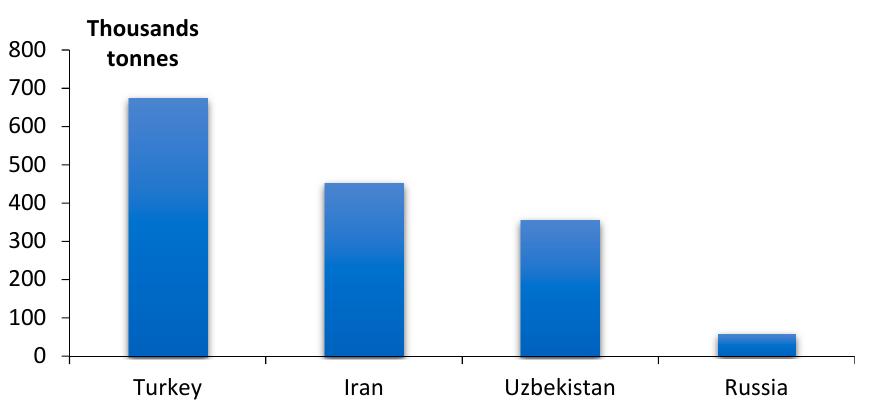
Figure 2. Apricot production in some countries (2018).